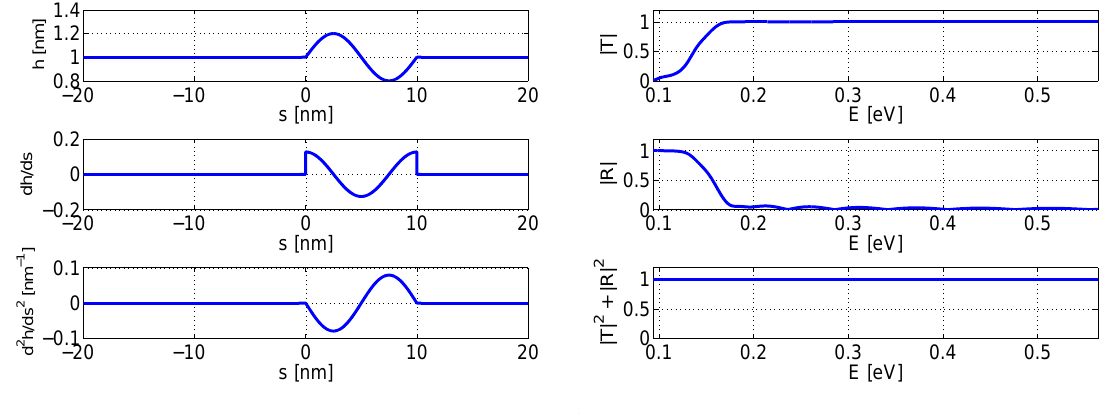
Figure 4. The case h 0 = 1nm, b = 2Å, L m = 10nm, and n = 2, (cid:101) =